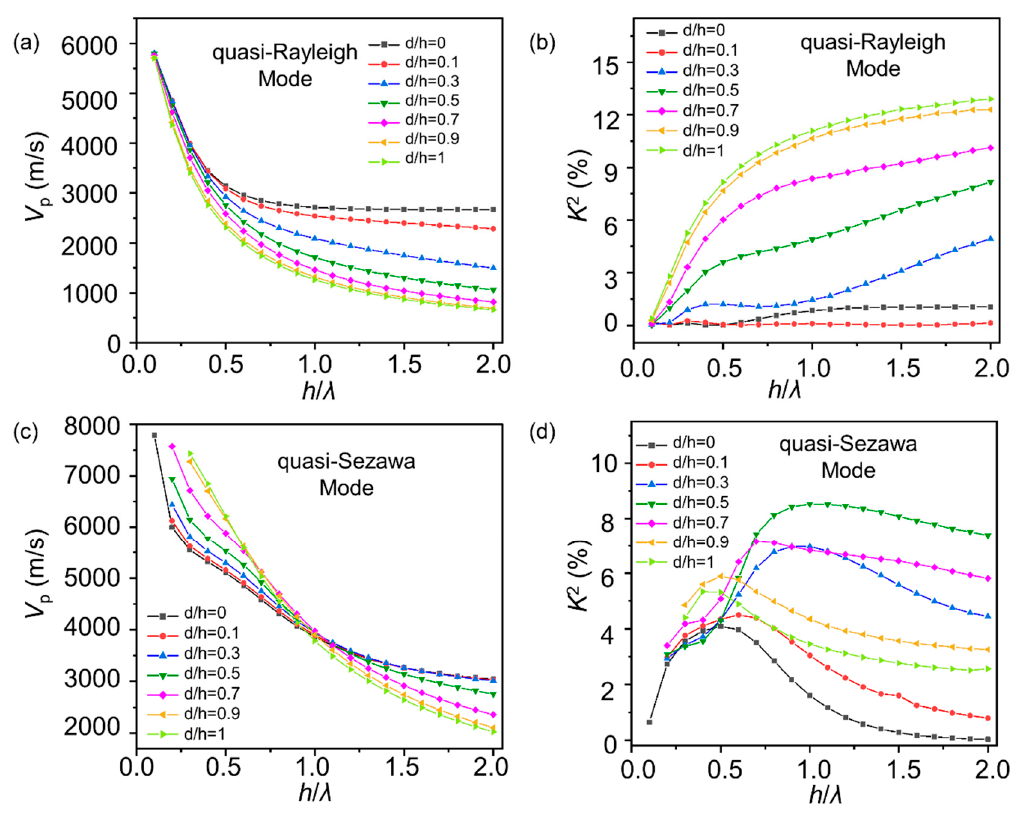
Figure 3. ( a , c ) V p and ( b , d ) K 2 of the quasi-Rayleigh mode ( a , b ) and quasi-Sezawa mode ( c , d ) as functions of different normalized ZnO thickness h / λ and etching ratio d / h simulated by FEM, when the top Al electrode thickness t 1 = 0.05 λ .